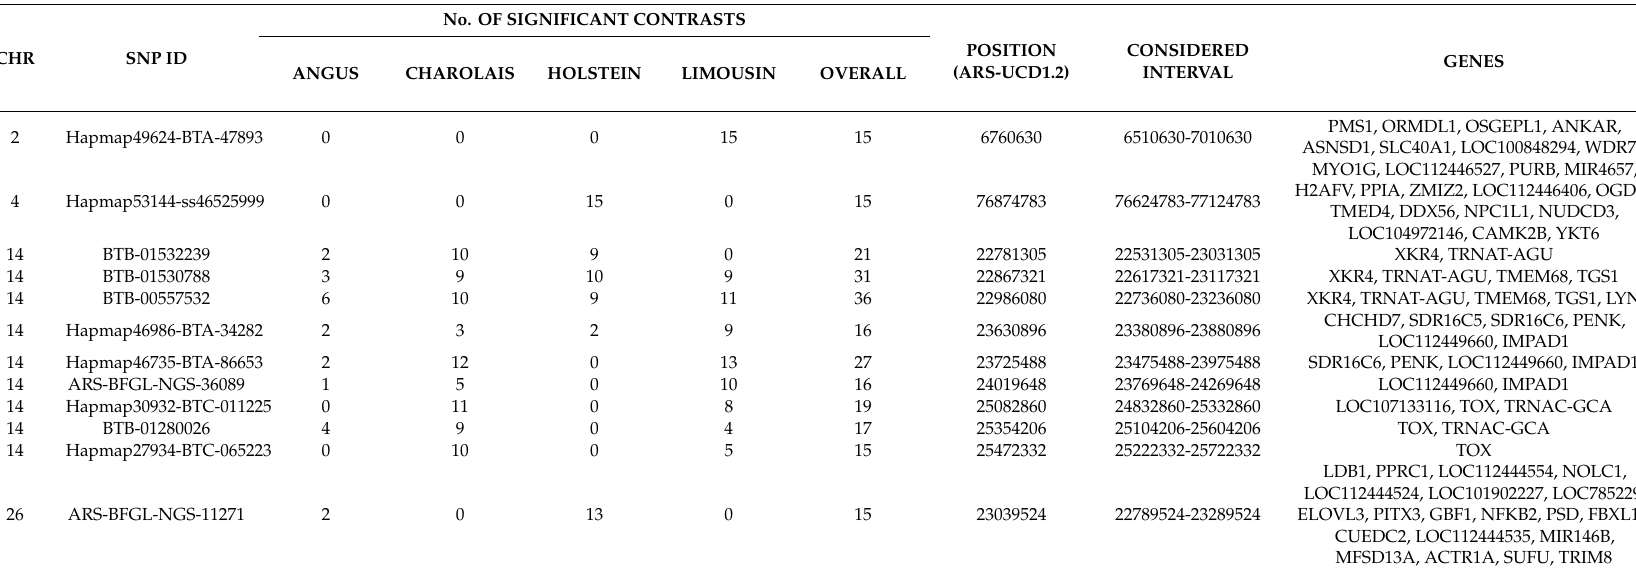
Table 2. Results of the F ST -outlier analysis performed contrasting 15 “grey” cattle breeds with each of the four selected “non-grey” cattle breeds (Angus, Charolais, Holstein, and Limousin). Only loci detected as significant ( q -value < 0.05) in at least 15 pair-wise contrasts out of 60 are